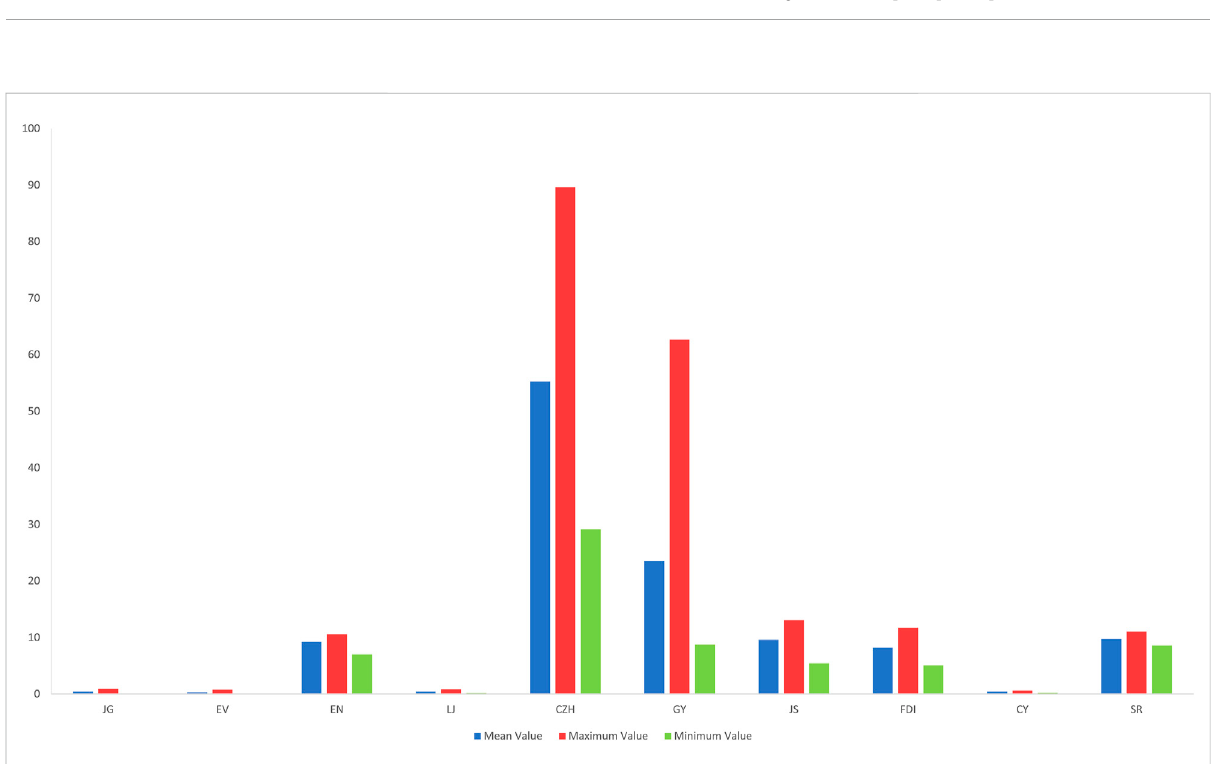
FIGURE 1 Descriptive statistical